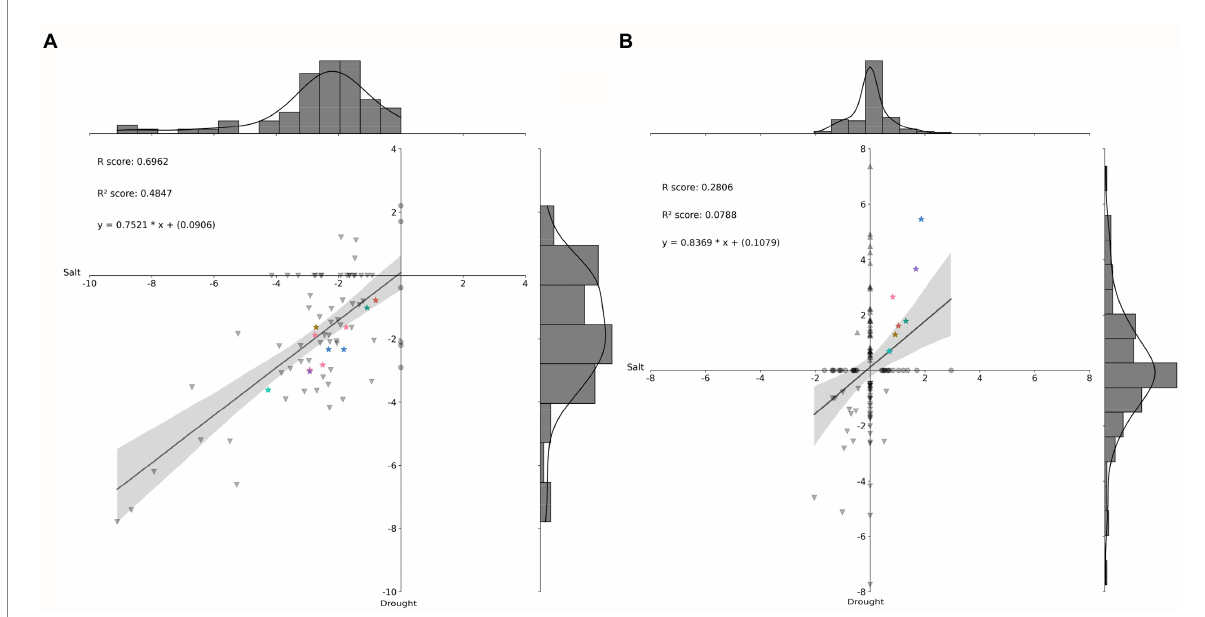
FIGURE 5 Histogram and correlation analysis of the Log 2 (FC) of differentially expressed (DE) miRNAs (A) and their respective DE putative target genes (B) , by pairwise comparison of two scenarios: Salt stress and Drought stress. Stars of same color identify miRNAs (in A) and their respective putative target genes upregulated in both stresses (in B). FC, Fold